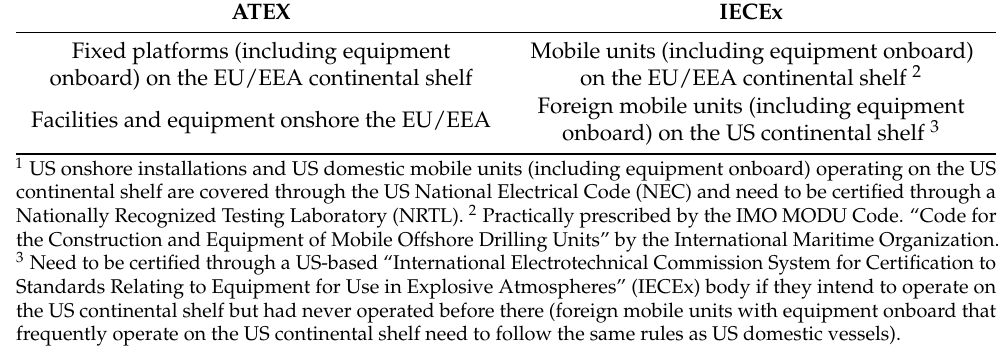
ATEX IECEx Fixed platforms (including